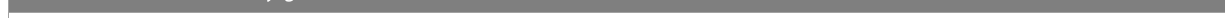
TABLE 1 Calcium metabolism family genes from GSEA database. Calcium metabolism family